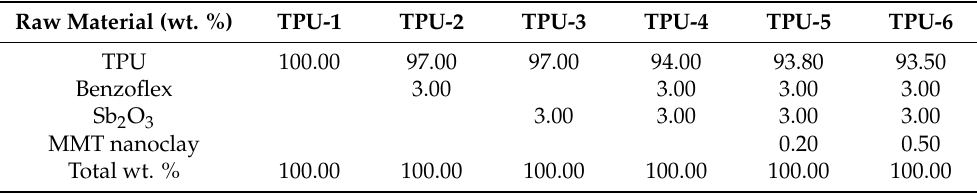
Table 1. The components and their ratios used for the experiment. Raw Material (wt.